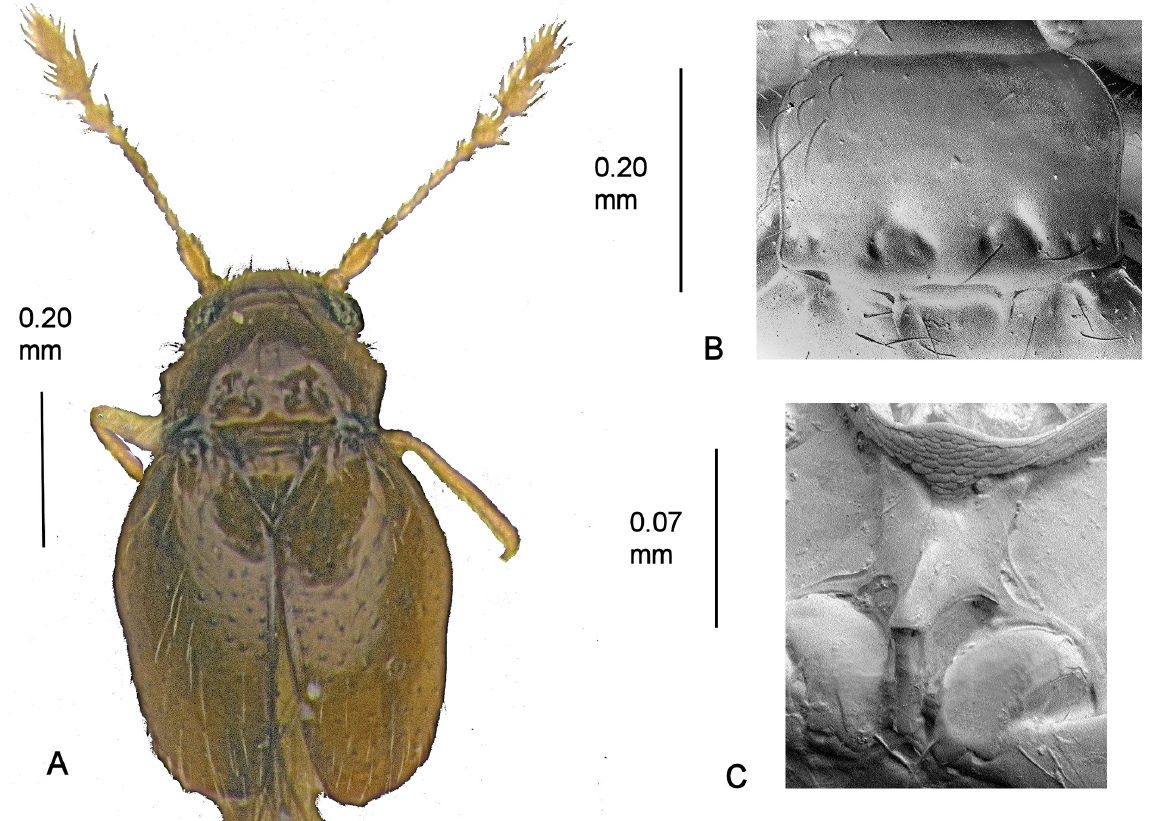
Fig. 13 . Cissidium advena sp. nov . A . Habitus. B . Pronotum, × 550. C . Mesoventrite showing median process of collar, mid-keel and keel, ×